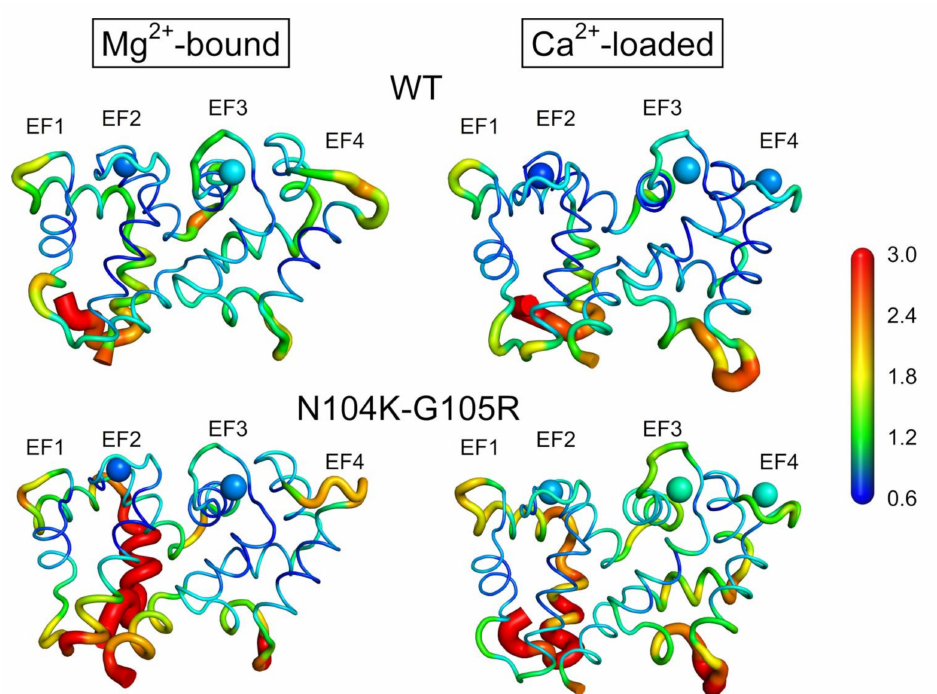
Figure 7. C α -root-mean-square fluctuation (RMSF) projected on the 3D structure of GCAP1 WT (upper panels) and N104K- G105R (lower panels) in their activating (Mg 2+ -loaded, left) and inhibiting (Ca 2+ -loaded, right) states. Protein structure is displayed as a tube cartoon with diameter proportional to the RMSF; Mg 2+ and Ca 2+ ions are shown as spheres. Structures are colored in a rainbow scheme representing RMSF values from 0.6 to 3 Å (see Figure S4 for C α -RMSF